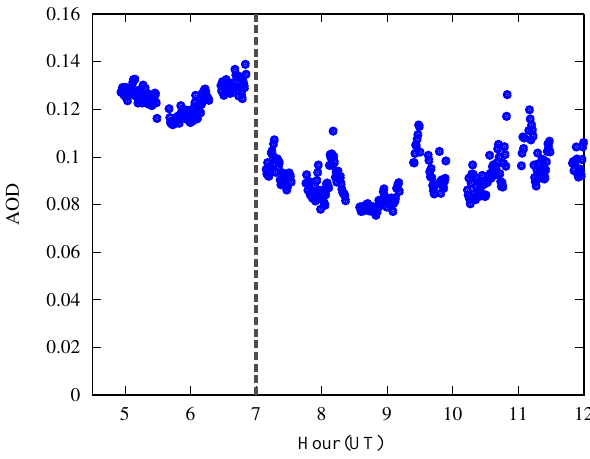
Figure 14. Effect of cleaning the Brewer quartz window from dust (day 127). The vertical line shows the time when the window was cleaned.